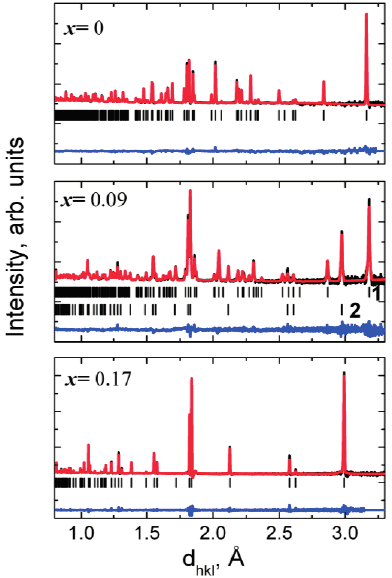
Figure 2. Diffraction patterns for the Zr 1- x Ce x O 2 samples measured using HRFD at room temperature, the data were treated using a Fullprof program. The experimental and calculated diffractograms and the difference between calculated and observed diffractograms are shown. The difference is weighted by the mean-squares deviation for each point. Below each graph, ticks indicate the position of the calculate peaks for each phase. 1—monoclinic structure (P2 1 /c (SG 14)); 2—tetragonal structure (P4 2 /nmc (SG 137)). Table 1. Refined structural parameters of Zr 1- x Ce x O 2 ( x = 0.0–0.17) at room